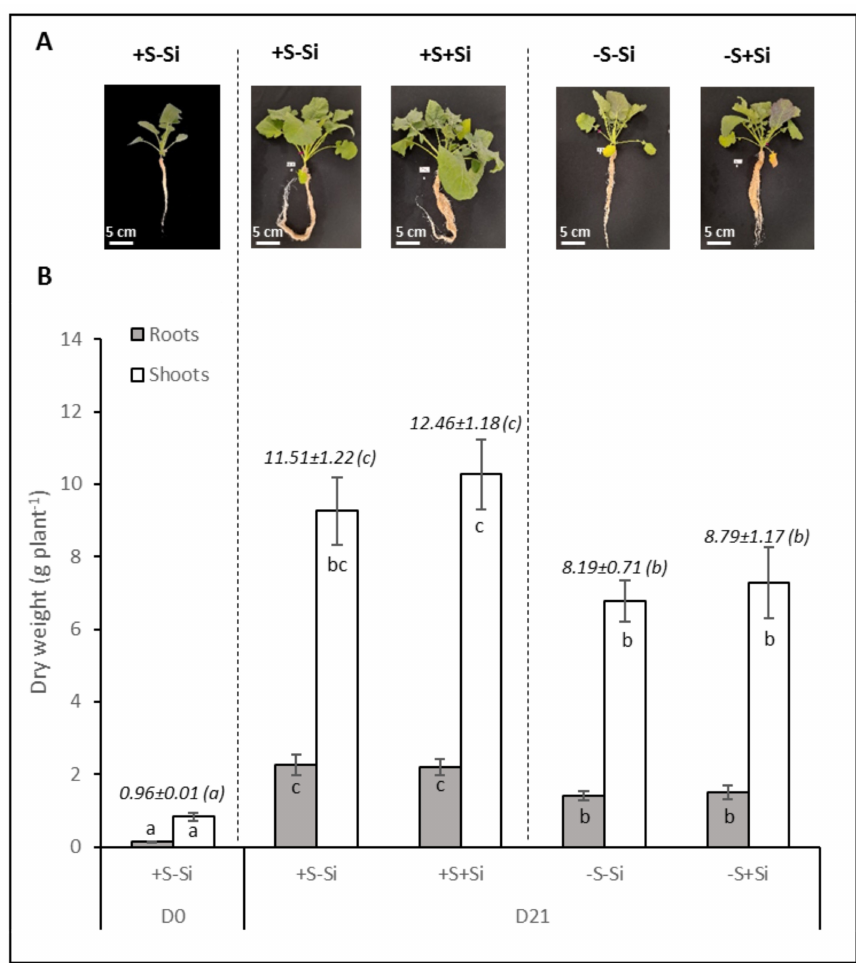
Figure 1. Representative pictures ( A ) and dry weights ( B ) of roots and shoots of Brassica napus L. plants cultivated in hydroponic conditions for 21 days (from D0 to D21) with (+S; 500 µ M) or without sulfur (–S; 0 µ M) and with (+Si; 1.7 mM) or without silicon (-Si) supply. Italic values indicate the whole plant biomass. Data are means ± SE (n = 4). Different Latin letters indicate that the mean dry weight of whole plant or of each plant compartment (roots or shoots) are significantly different ( p <